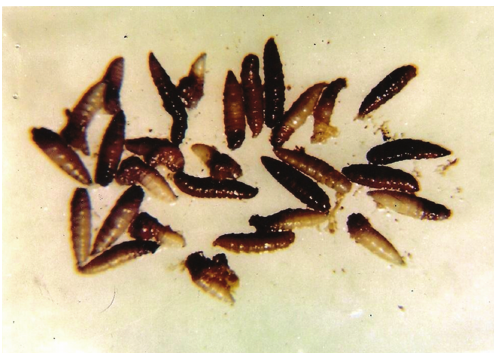
Figure 3: W. magnifica maggot removed from eye lid after surgery.